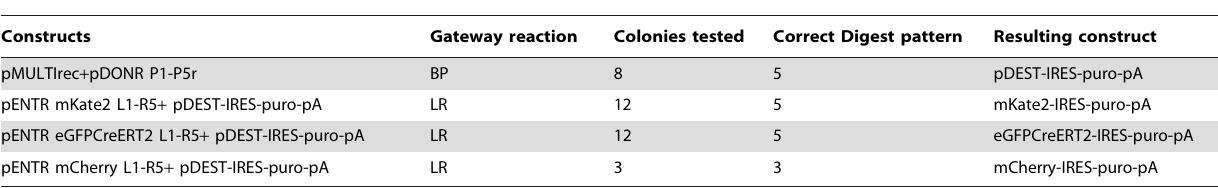
Table 2. Efficiency of the Gateway reactions used.